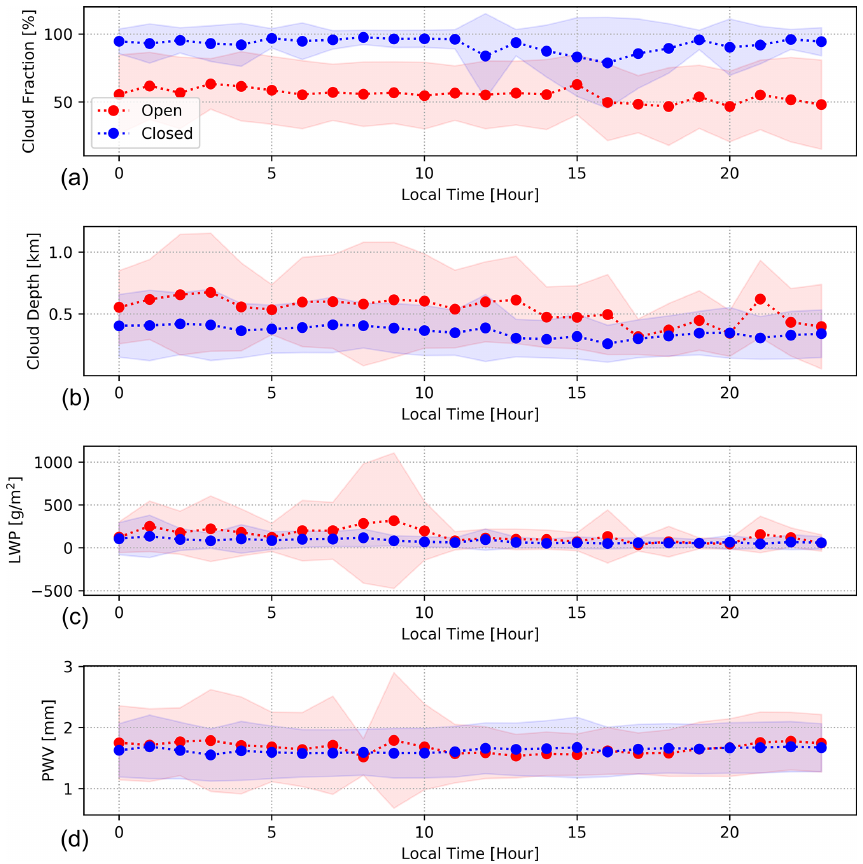
Figure 9. Diurnal cycle of the mean and standard deviation of the (a) 1-D cloud fraction (%), (b) cloud depth (or thickness) (km), (c) liquid water path (gm − 2 ) and (d) precipitable water vapor (mm) for open-cell (red) and closed-cell (blue) cases. The markers represent the mean values, and the shadings represent the 1 σ standard